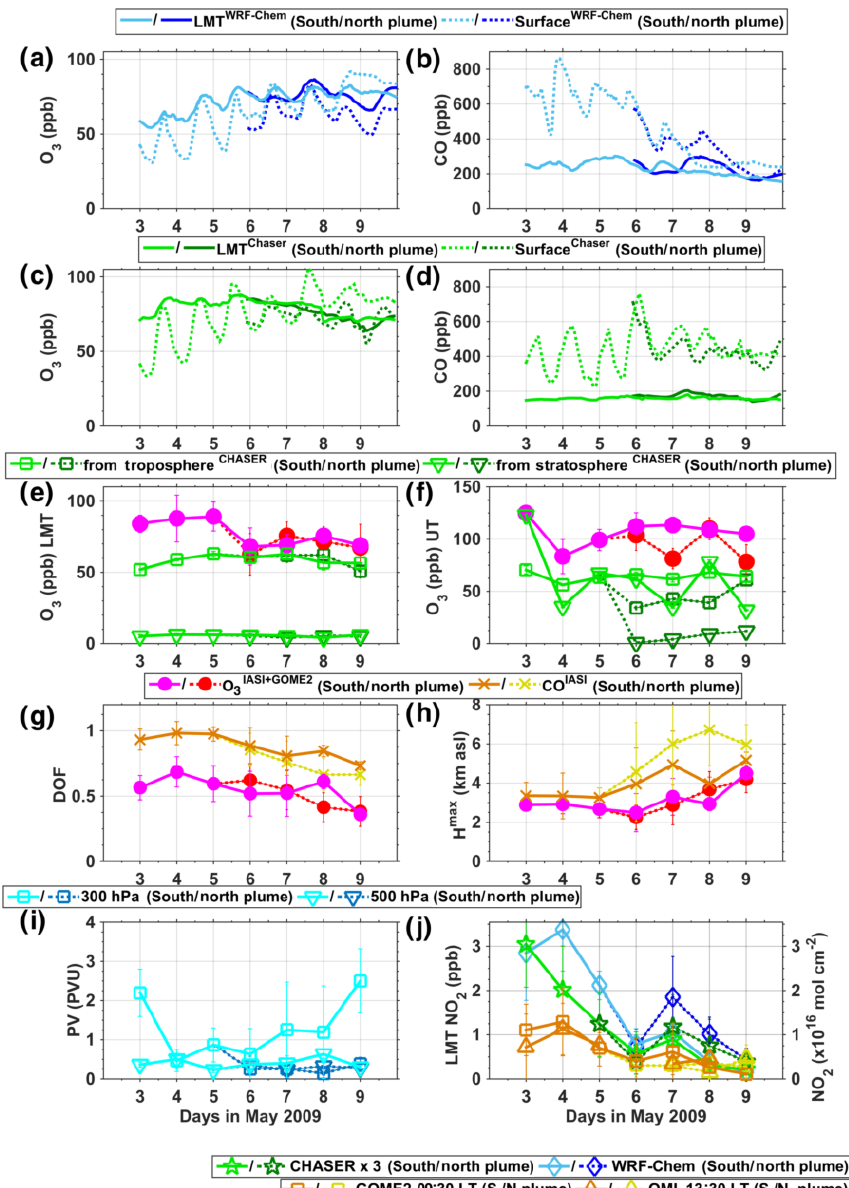
Figure 14. Lagrangian evolution at the location of the pollution plumes across East Asia (rectangles in Figs. 5 and 7–11) on 3–9 May 2009 for the following variables: (a, c) O 3 and (b, d) CO mixing ratios in the LMT (plain lines) and the surface (dotted lines) from WRF-Chem (panels a and b ) and CHASER analysis (panels c and d ), for the southern (lighter colours) and northern (darker colours) pollution plumes. Ozone burden in the (e) LMT and the (f) upper troposphere (UT), observed by IASI + GOME2 (magenta and red for the southern and northern plumes respectively) and simulated by CHASER for air masses originating from the troposphere (squares) and stratosphere (triangles). Satellite retrieval sensitivity in term of (g) degrees of freedom and (h) heights of maximum sensitivity in the LMT and LT for respectively IASI + GOME2 and IASI. In panel (g) , DOF for IASI + GOME2 are multiplied by a factor of 2 for visual clarity. (i) Potential vorticity at 300 (squares) and 500hPa (triangles) from ERA-I reanalysis. (j) NO 2 concentrations observed as total columns by GOME-2 at 09:30JLT (squares) and OMI at 13:30JLT (triangles) and derived from WRF-Chem (ovals) and CHASER analyses (stars, multiplied by a factor of 3 for visual clarity) in the LMT at 10:00JLT. In panels (e–j) , curves with lighter and darker colours but the same marker correspond to respectively the southern and northern pollution plumes. We show mean values and SDs ( ± vertical bars) over the areas depicted by rectangles in Figs. 5 and 7–11 for each of the days of the pollution